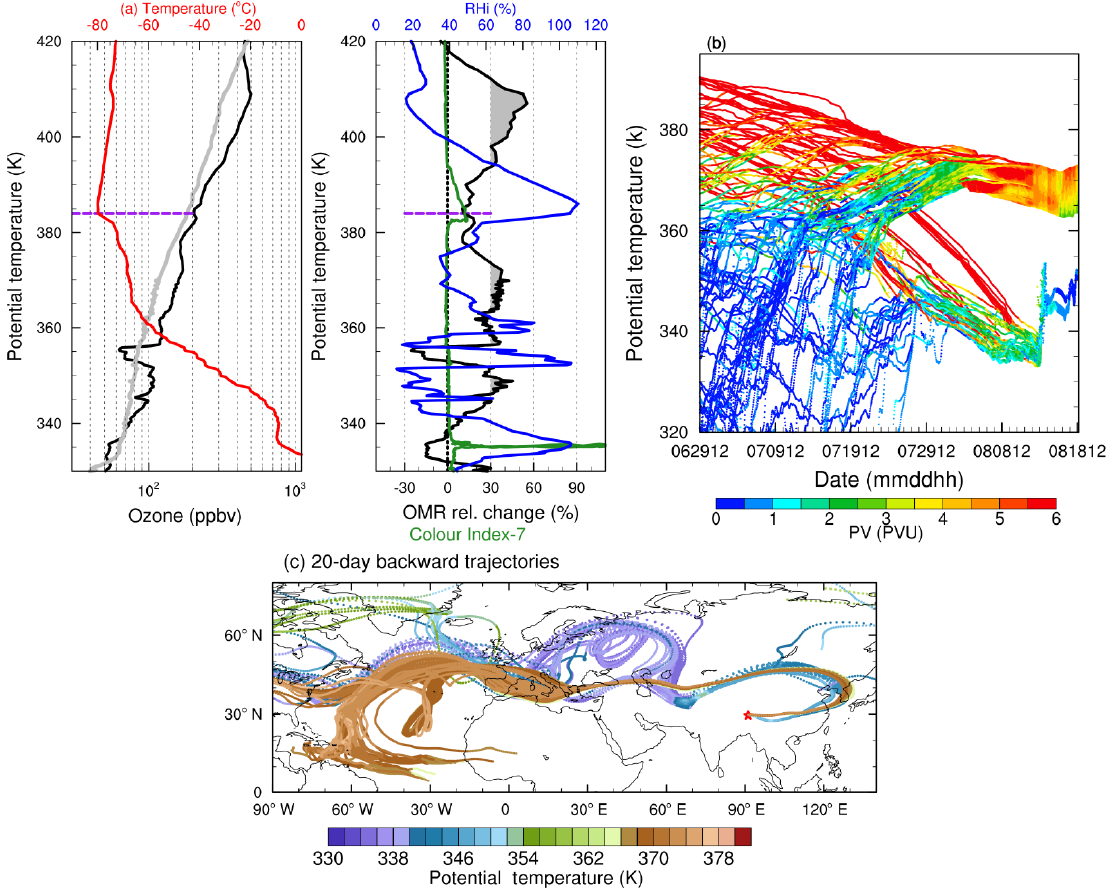
Figure 5. Panels (a, b) are the same as Fig. 3a–b but on 18 August 2013. (c) The 20-day backward trajectories of air parcels within the high ozone layer are shown colour-coded by potential